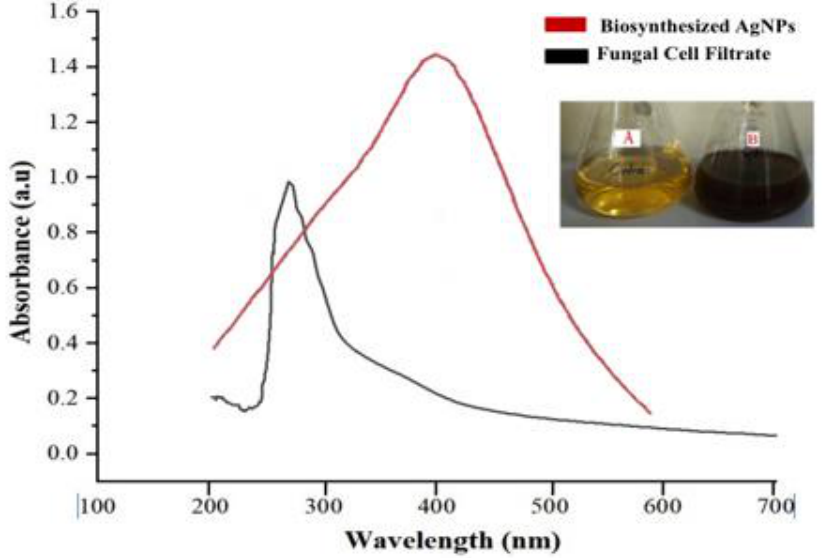
Figure 3. UV–vis absorption spectra of fungus cell filtrate and biosynthesised AgNPs. ( A ). Aqueous extract of P . lilacinum; ( B ). Reaction mixture containing AgNO3 and P . lilacinum extract.